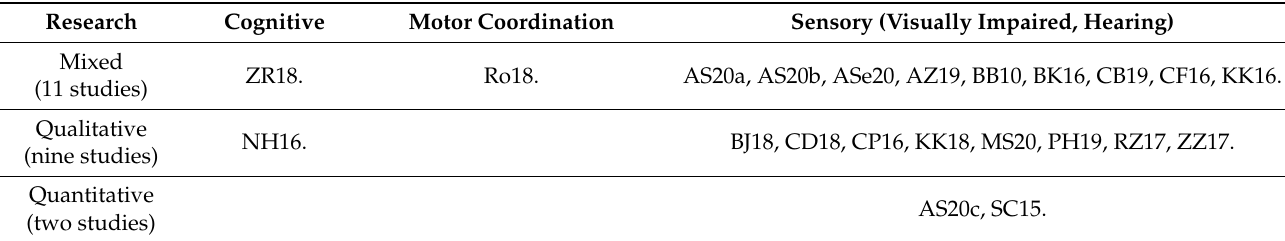
Table 8. The research was employed for the design of accessible mobile